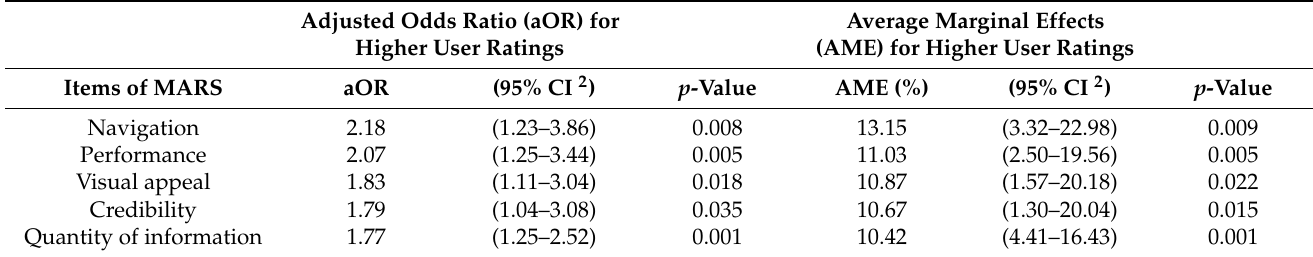
Table 3. Adjusted odds ratio (aOR) and average marginal effects (AME) of items of Mobile App Rating Scale